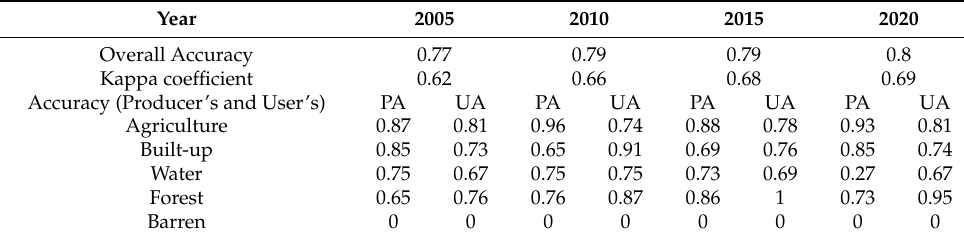
Table 3. Results of accuracy assessment for different land cover types and